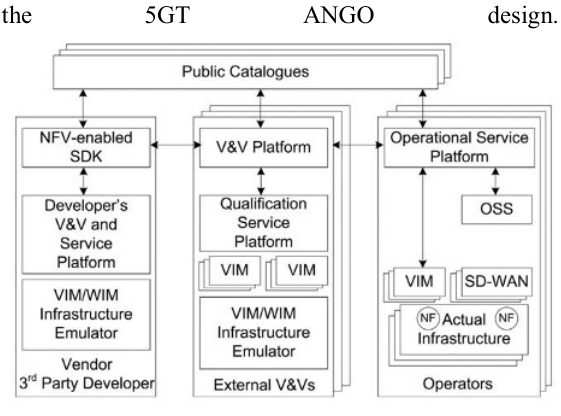
Fig. 3. 5GTANGO architecture